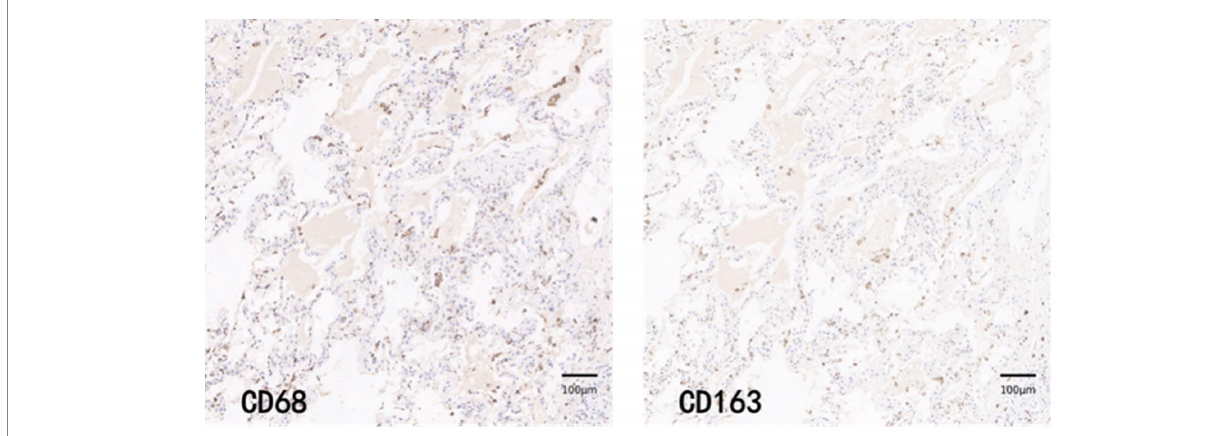
FIGURE 9 COV-L group immunohistochemical staining PATCH (1,600 × 1,600 pixels).